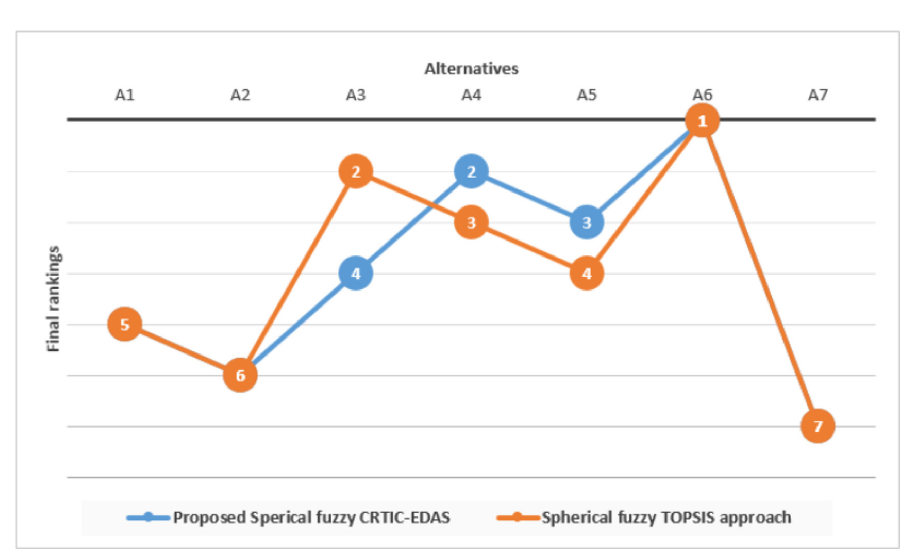
Fig 3. Criterion weights for different decision-expert weight distribution scenarios.